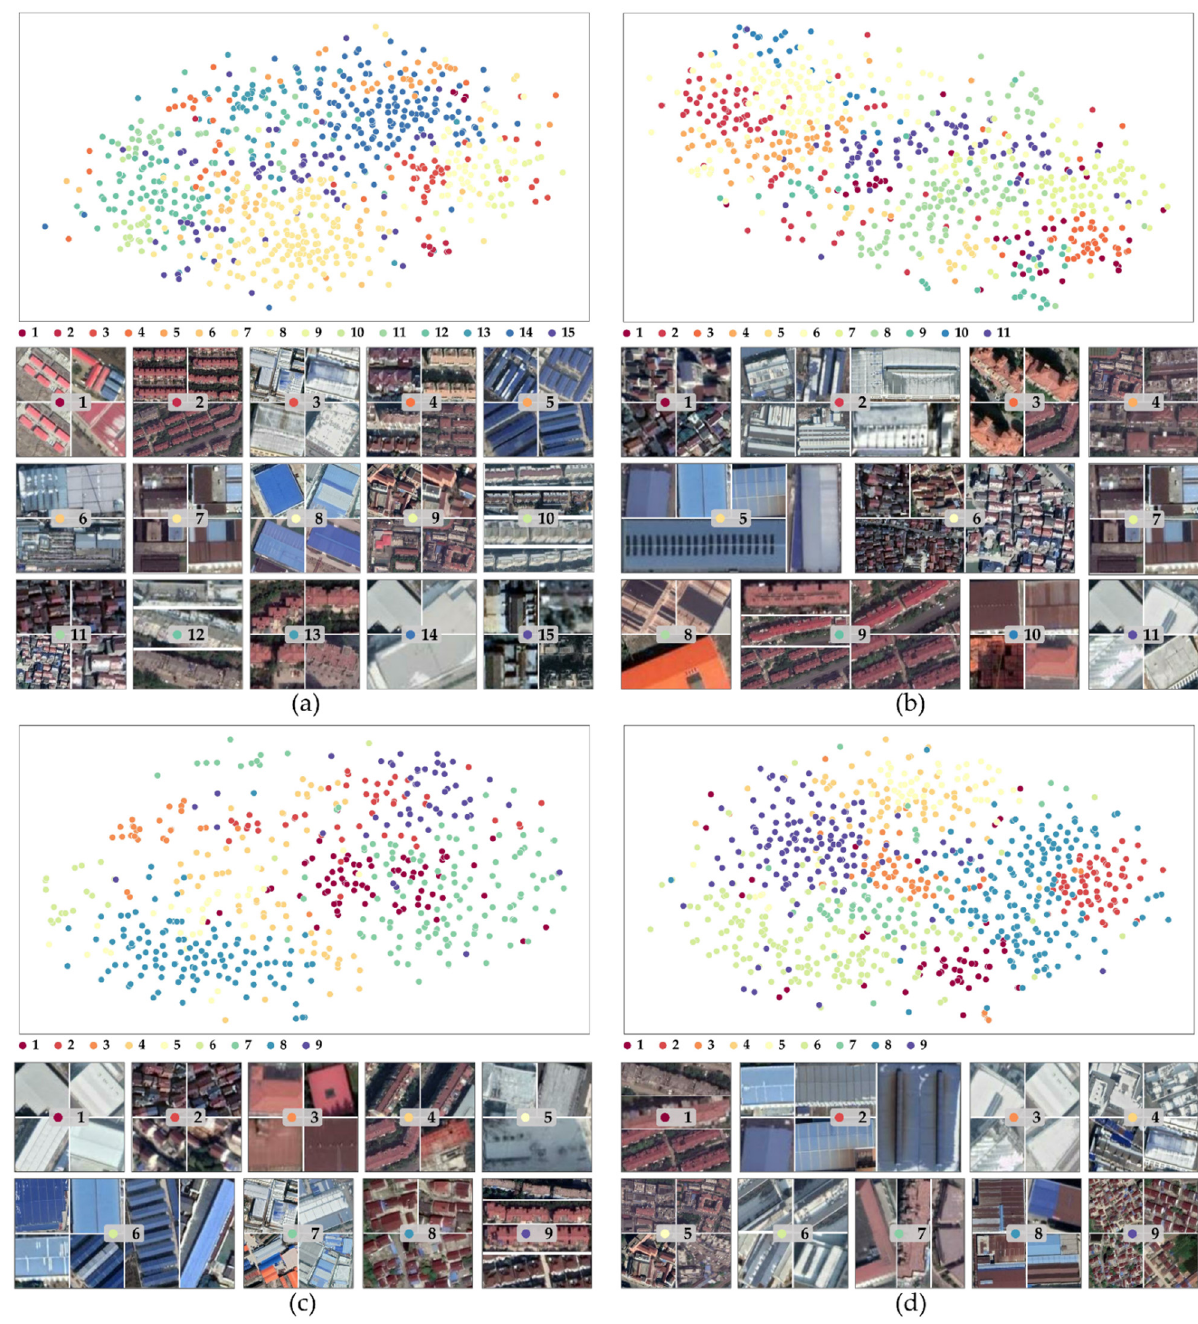
Figure 7. TSNE plots of rooftop image patches based on KMeans clustering and partial image patches of each class. ( a ) TSNE plots and partial image patches of the GSOS; ( b ) TSNE plots and partial image patches of the SRSS; ( c ) TSNE plots and partial image patches of the DOS; ( d ) TSNE plots and partial image patches of the